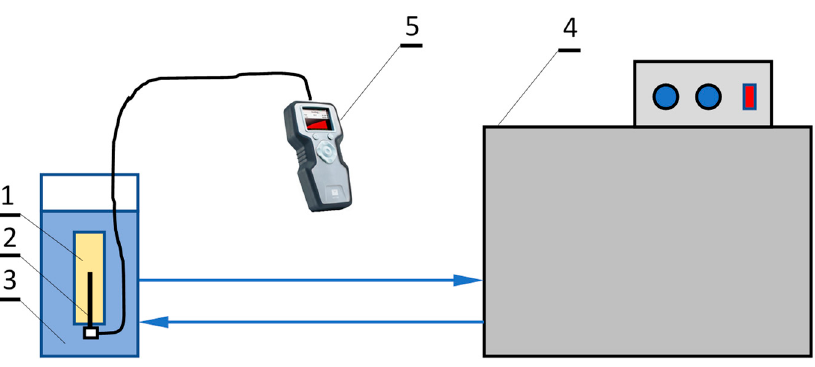
Figure 1. Diagram of the test stand; 1—tested slurry, 2—probe needle, 3—water bath, 4—cryostat, 5—TEMPOS thermal properties analyzer (METER Group, Inc., Pullman, WA, USA).